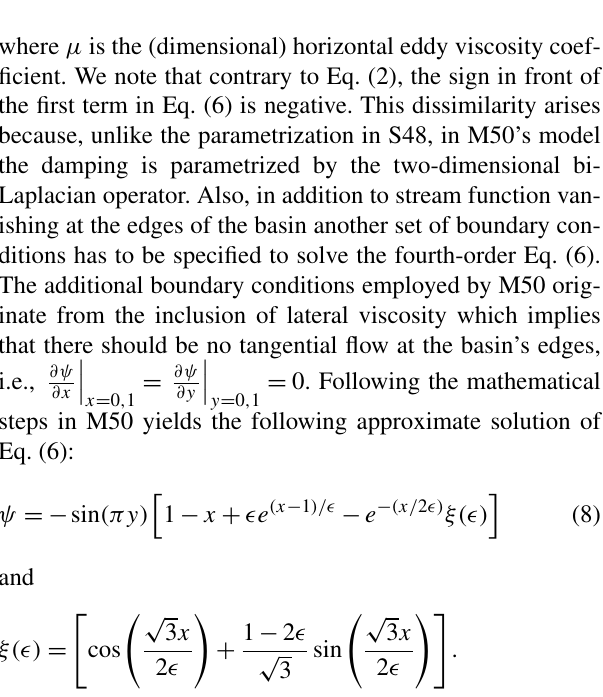
Figure 1. The stream functions in different (cid:15) regimes of S48’s and M50’s models for δ = 2 π/ 10: (a) and (b) weak damping ( (cid:15) ≤ δ 2 in S48’s model and (cid:15) ≤ 0 . 1 δ 4 / 3 in M50’s model) – there exists a narrow fast flowing current along the western edge of the basin; (c) and (d) strong damping ( (cid:15) > δ 2 in S48’s model and (cid:15) > 0 . 1 δ 4 / 3 in M50’s model) – the stream function is (nearly) symmetric about x = 0 . 5, which indicates that there is no westward